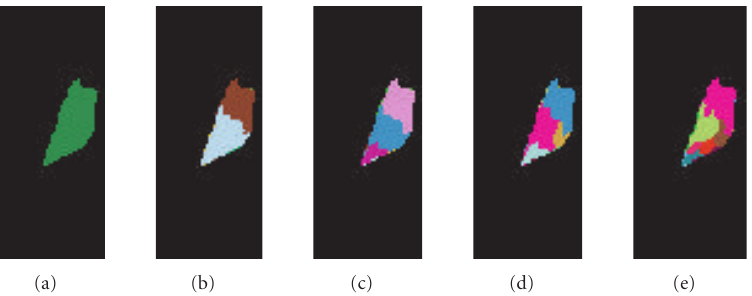
Figure 2: Mean shift based hierarchical thalamus nuclei segmentation results of the left thalamus. (a) The segmented left thalamus by setting the bandwidth parameter as h = ( h s , h r ) = (7,13) . (b) The segmented anterior and posterior parts of the left thalamus by setting the bandwidth parameter as h = ( h s , h r ) = (7,11) . (c) The segmentation result by setting the bandwidth parameter as h = ( h s , h r ) = (7,10 . 5) . (d) The segmentation result by setting the bandwidth parameter as h = ( h s , h r ) = (7,10) . (e) The segmented thalamus nuclei by setting the bandwidth parameter h = ( h s , h r ) = (7,8) .